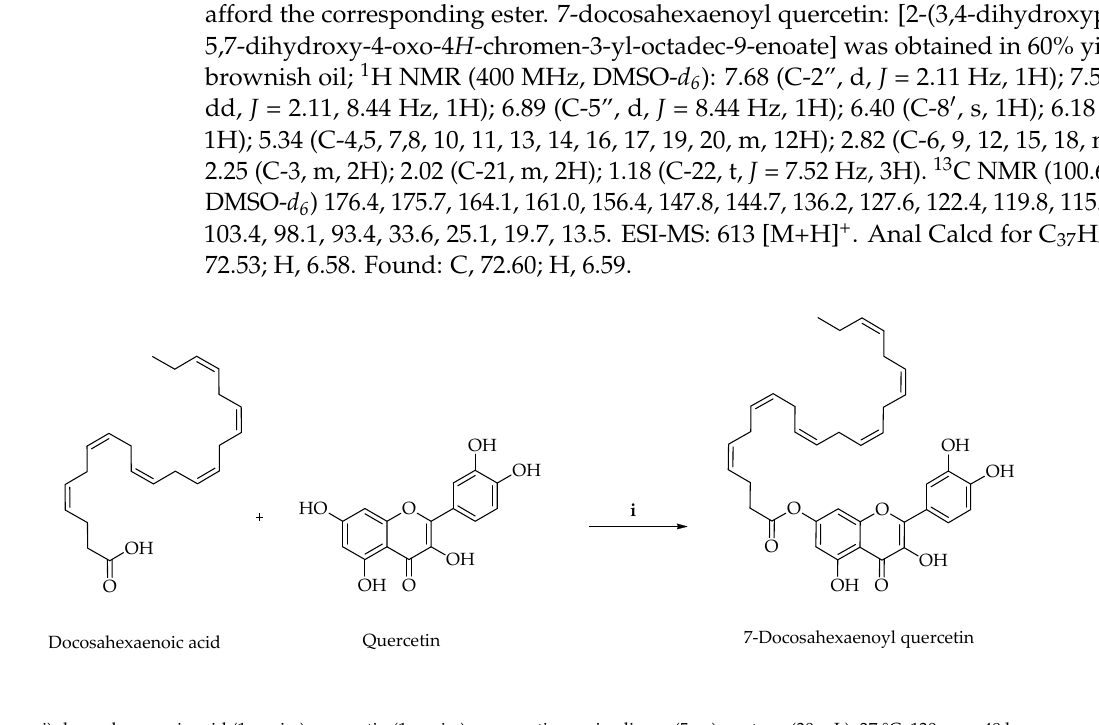
Figure 2. Synthesis of 7-docosanoylquercetin. Supplementary Materials: The following are available online, Figure S1: 1 H-NMR spectrum; Figure S2: 13 C-NMR spectrum.